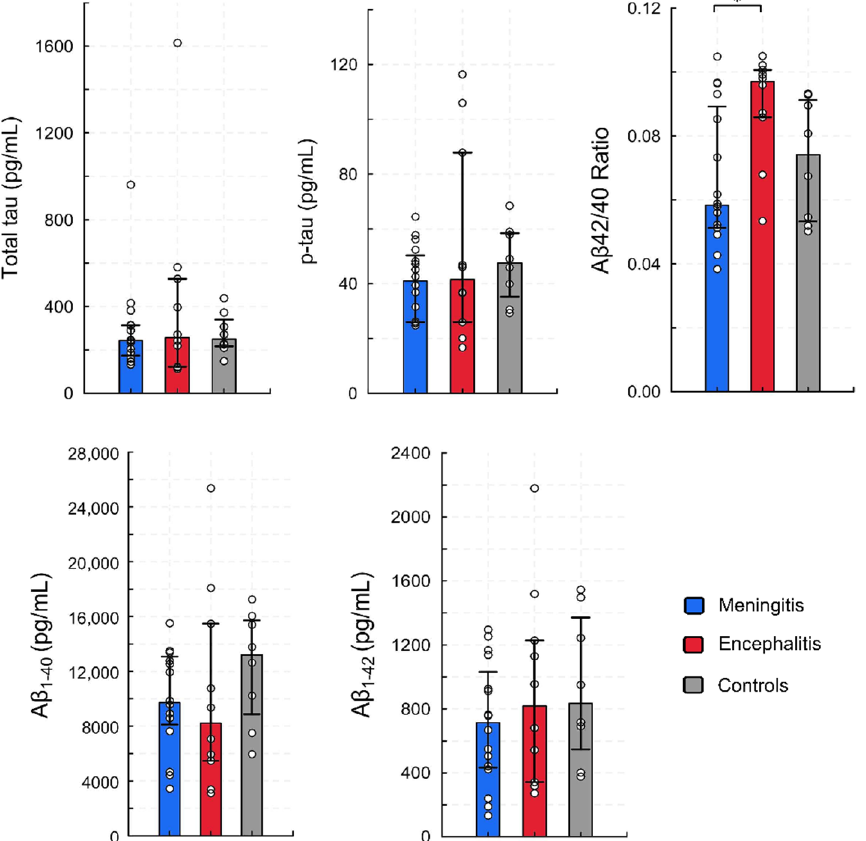
Figure 3. Cerebrospinal fluid concentrations of biomarkers of Alzheimer’s disease in children with infections of the central nervous system, divided by the severity of infection. In this comparison, only children with viral causes were included. The meningitis group ( n = 16) comprises children with enteroviral meningitis ( n = 10), varicella zoster virus meningitis ( n = 3), and tick-borne encephalitis ( n = 3). The encephalitis group ( n = 10) comprises children with enteroviral encephalitis ( n = 2), varicella zoster viral encephalitis ( n = 2), and tick-borne encephalitis ( n = 6). Bars represent medians, whiskers represent interquartile range, and dots show the raw data. * indicates p < 0.05.